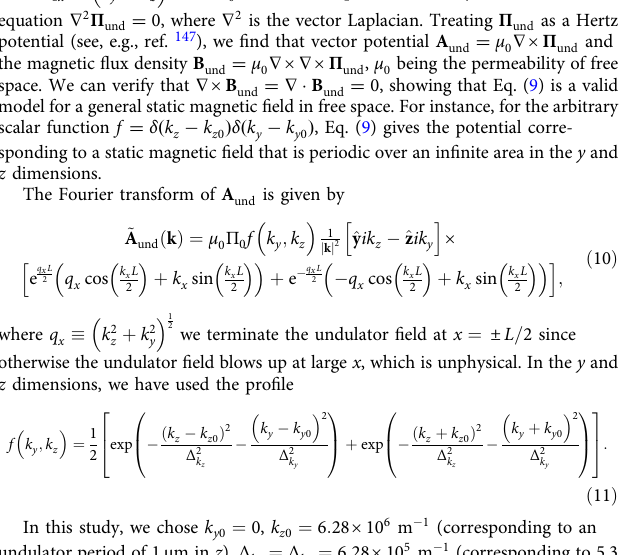
¼ μ ¼ 0) for 1 2